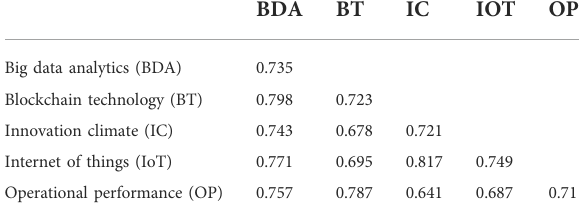
TABLE 7 Path coef fi cients of model with interaction of innovation